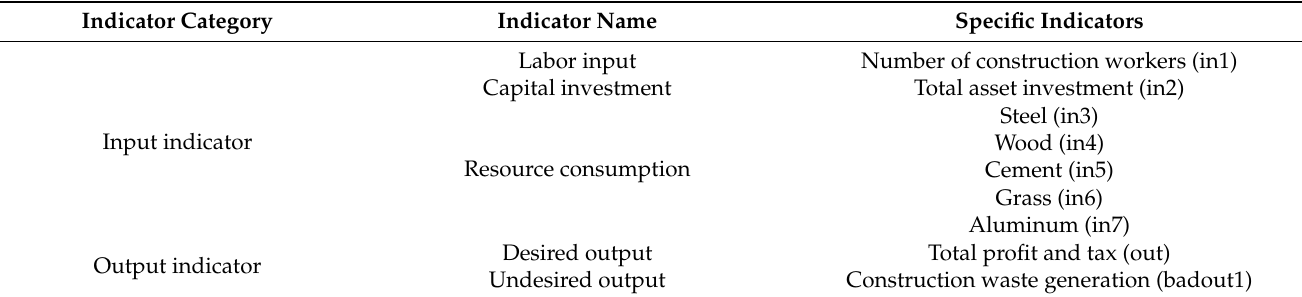
Table 1. System of input and output indicators.